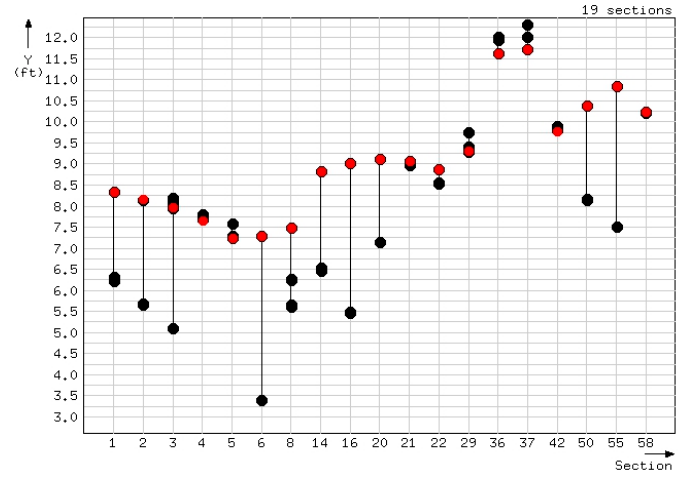
Figure 14. Dataset 3: Critical depths of case 2 sections. Figure 14 . Dataset 3: Critical depths of case 2 sections Figure 14 . Dataset 3: Critical depths of case 2 sections